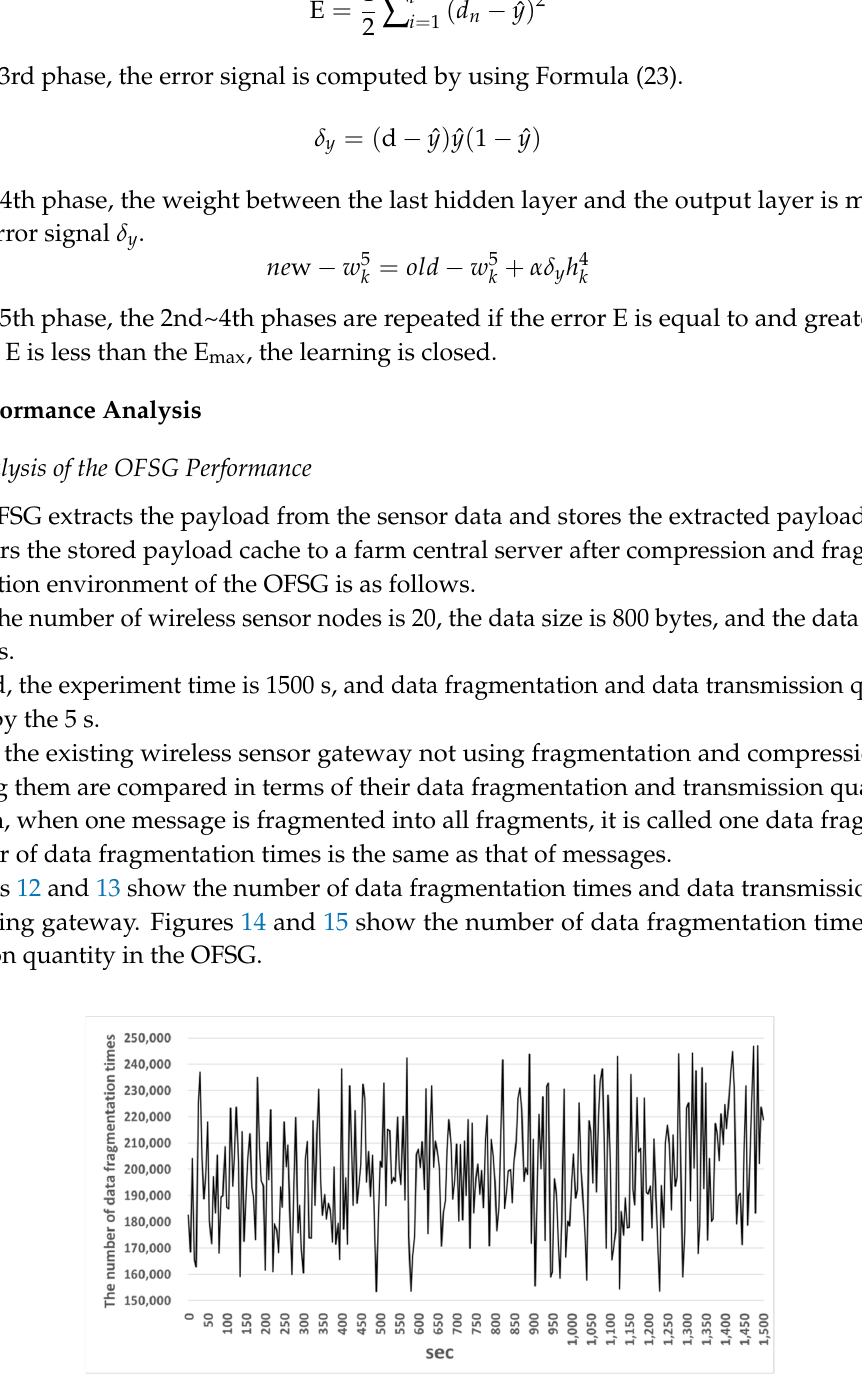
Figure 12. The number of data fragmentation times in the existing gateway.